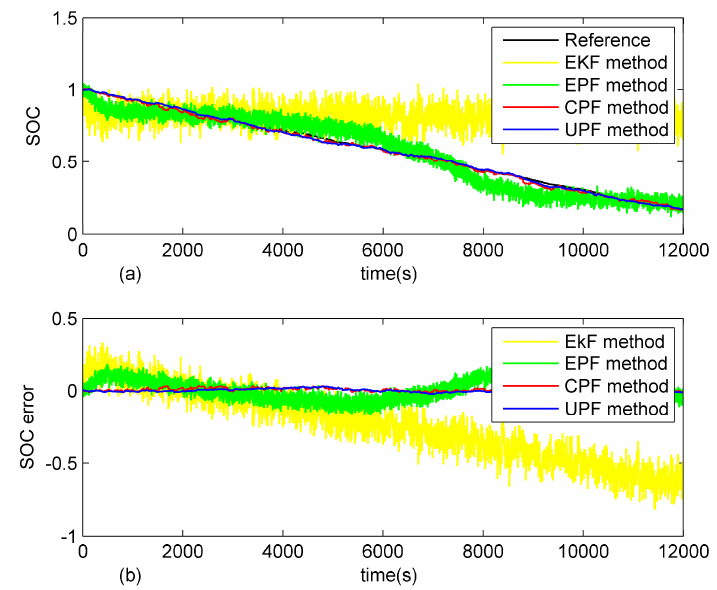
Figure 7. Comparison of estimation results of the four methods in a noisy environment: ( a ) SOC estimation; and ( b ) SOC estimation error. Table 3. Performance comparison of four methods in noise environment.